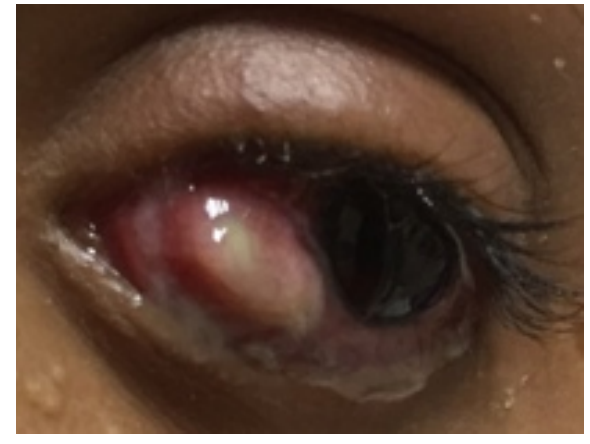
Figure 2: Ruptured subconjunctival abscess